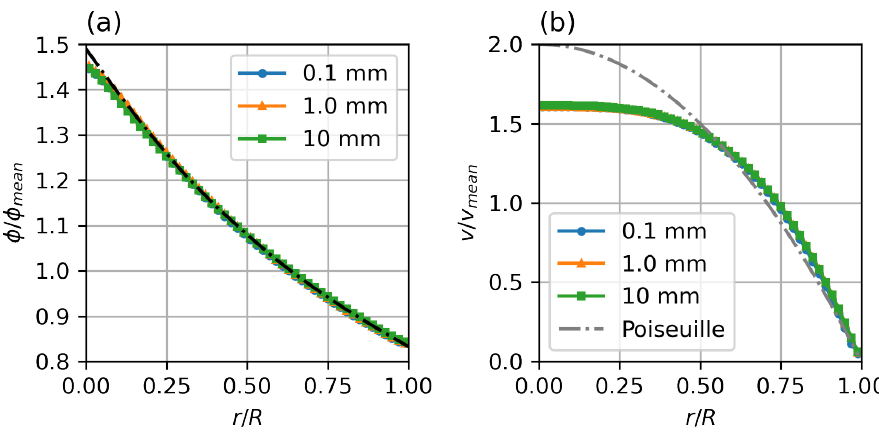
Figure 5. Steady state particle distribution ( a ) and velocity profiles ( b ) for different diameters. Parameters: fully developed pipe flow, R = 0.05, 0.5, 5 mm, V = 0.0065, 0.065, 0.65 m s − 1 , K c = 0.41, K µ = 0.62, n = 1.82, φ ∗ = 0.68, Standard Krieger–Dougherty